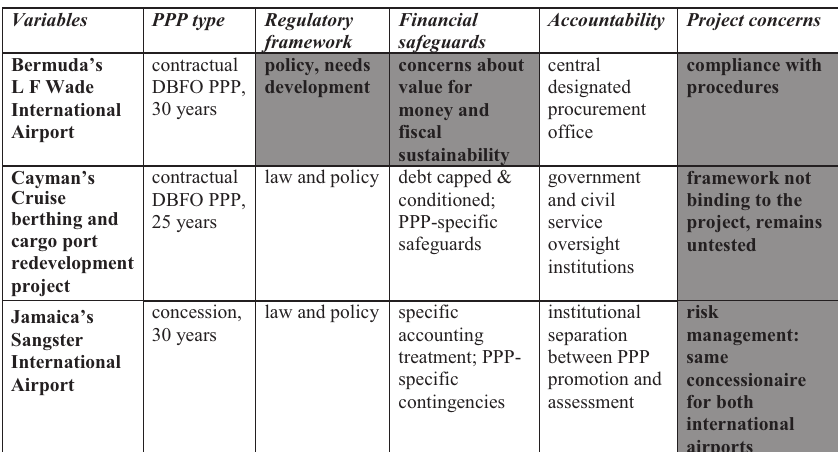
Figure 1. Summary of